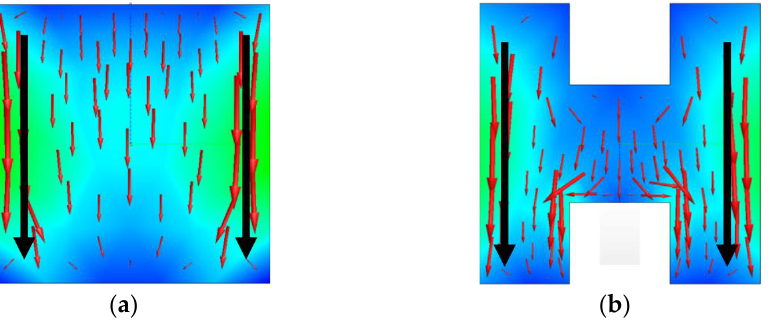
Figure 5. Radiation characteristic current distribution on the radiation patch at 5.1 GHz. ( a ) Reference antenna; ( b ) antenna A.